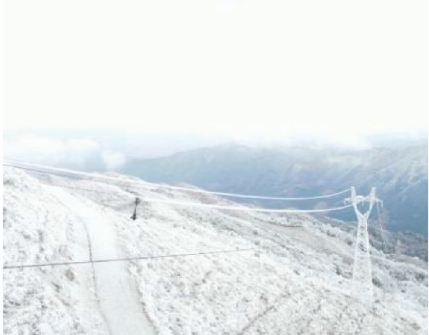
Figure 1: Atmospheric icing of conductors.